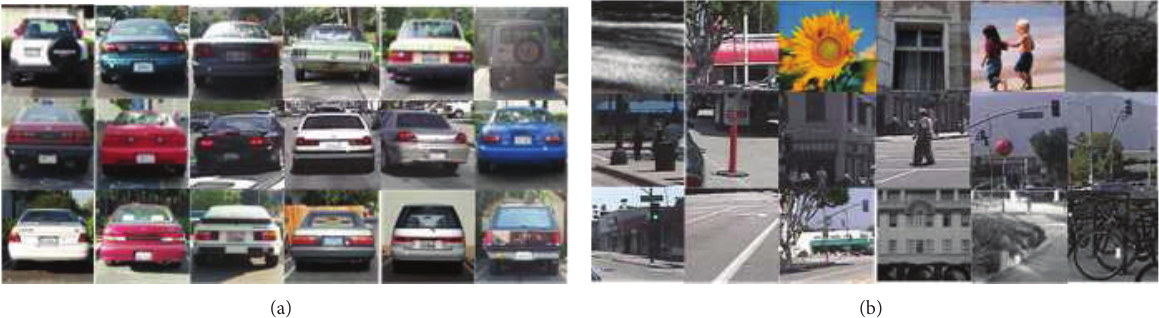
Figure 3: Some positive and negative training samples. (a) Positive samples. (b) Negative samples.